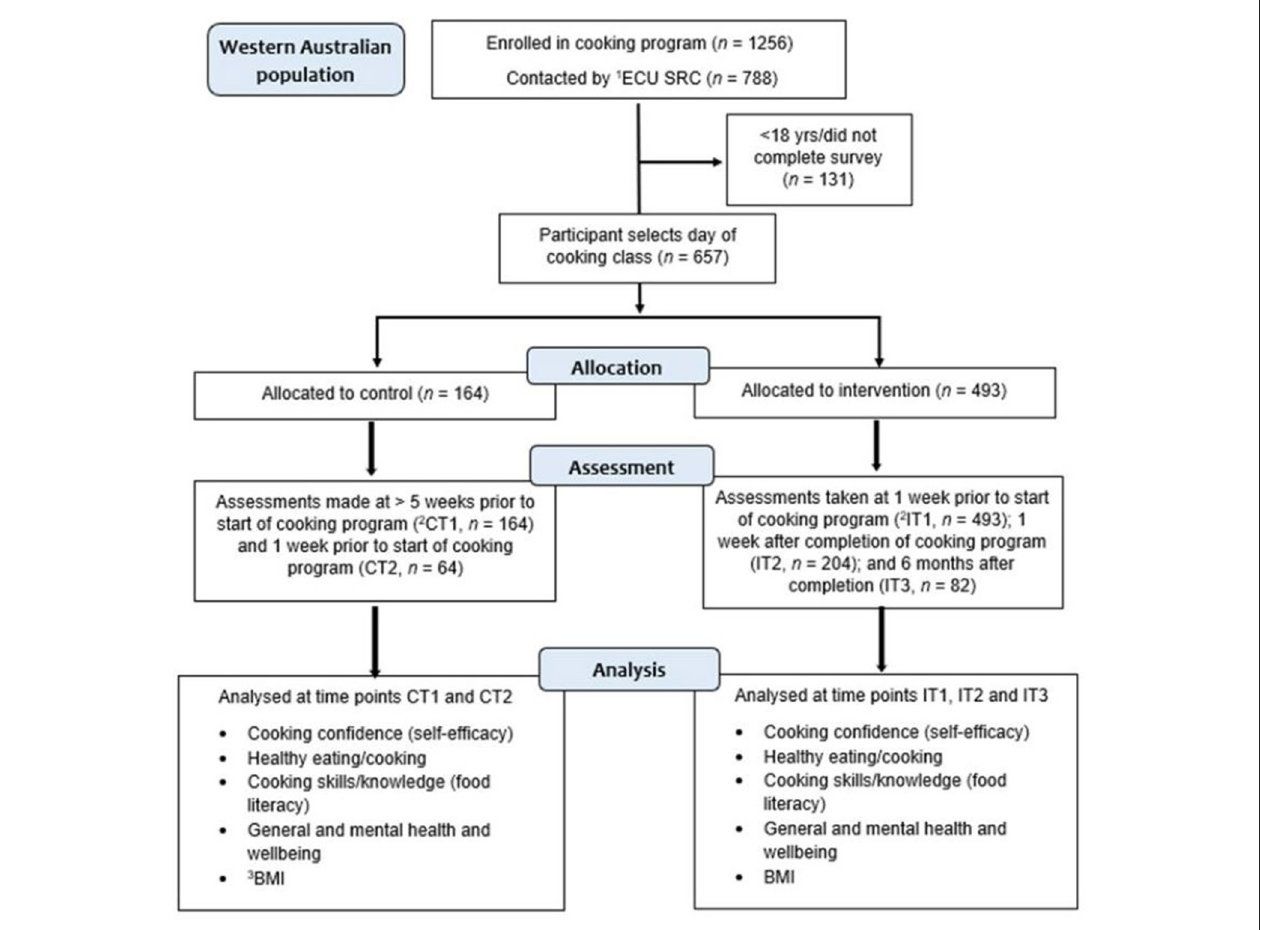
FIGURE 1 | Study flow diagram of participant enrolment, allocation, assessment and analysis over time. 1 ECU SRC, ECU Survey Research Centre; 2 CT1, CT2, IT1, IT2, IT3, control timepoint 1 and 2, intervention timepoint 1, 2 and 3; 3 BMI, body mass index.